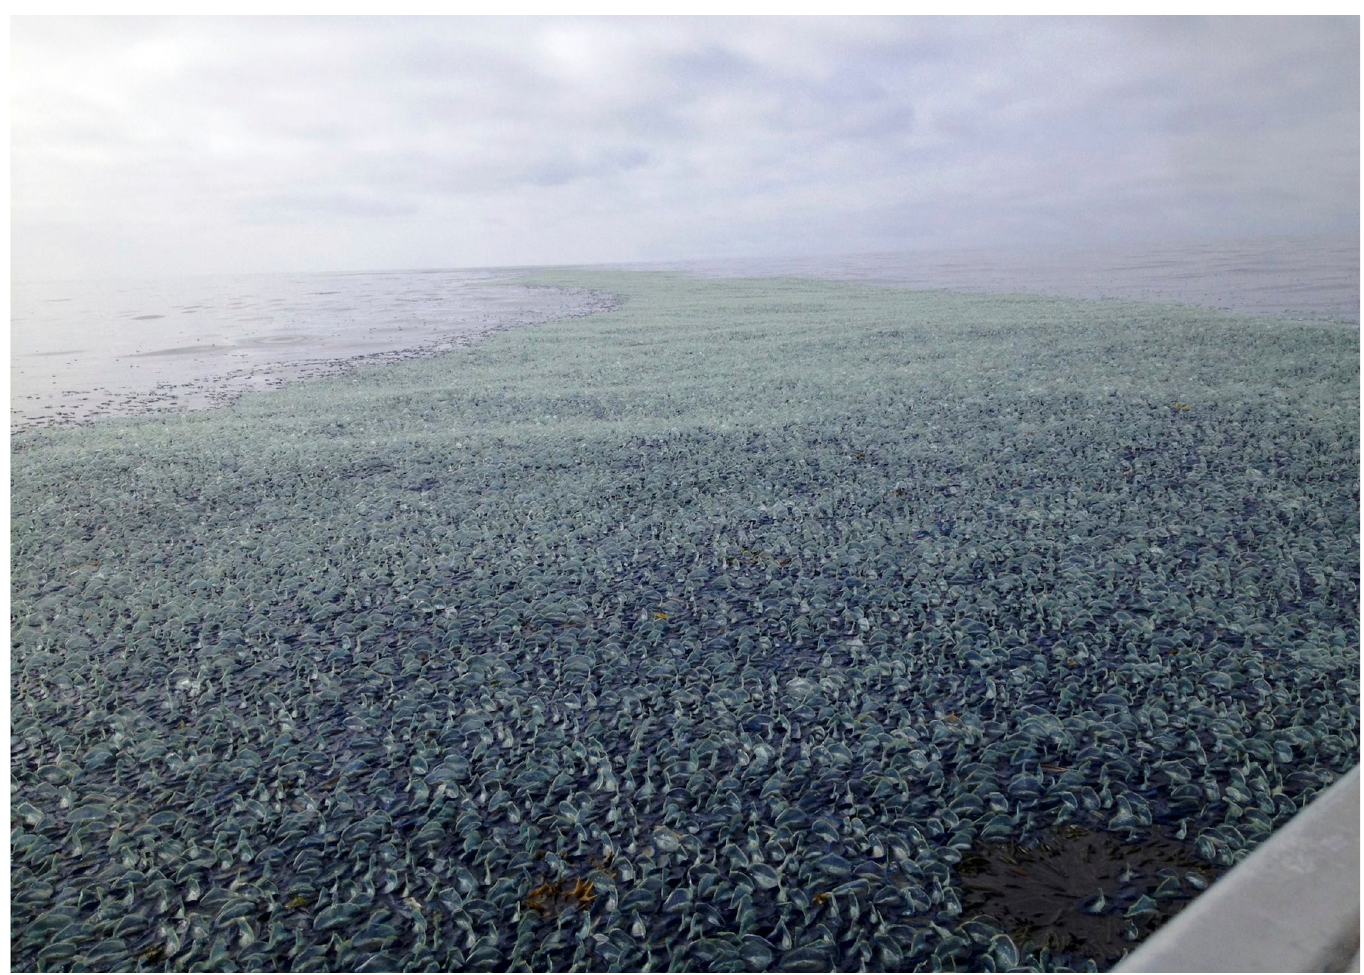
Fig 2. Neuston on the ocean’s surface. By-the-wind sailors Velella sp. covering the ocean’s surface off the coast of La Push, Washington State, United States of America. Image by Scott